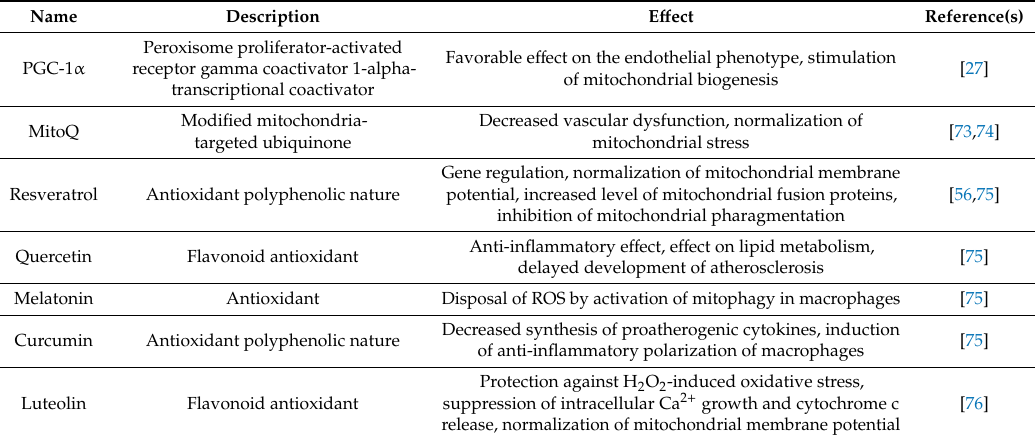
Table 2. Pharmacological agents targeting oxidative stress associated with mitochondrial